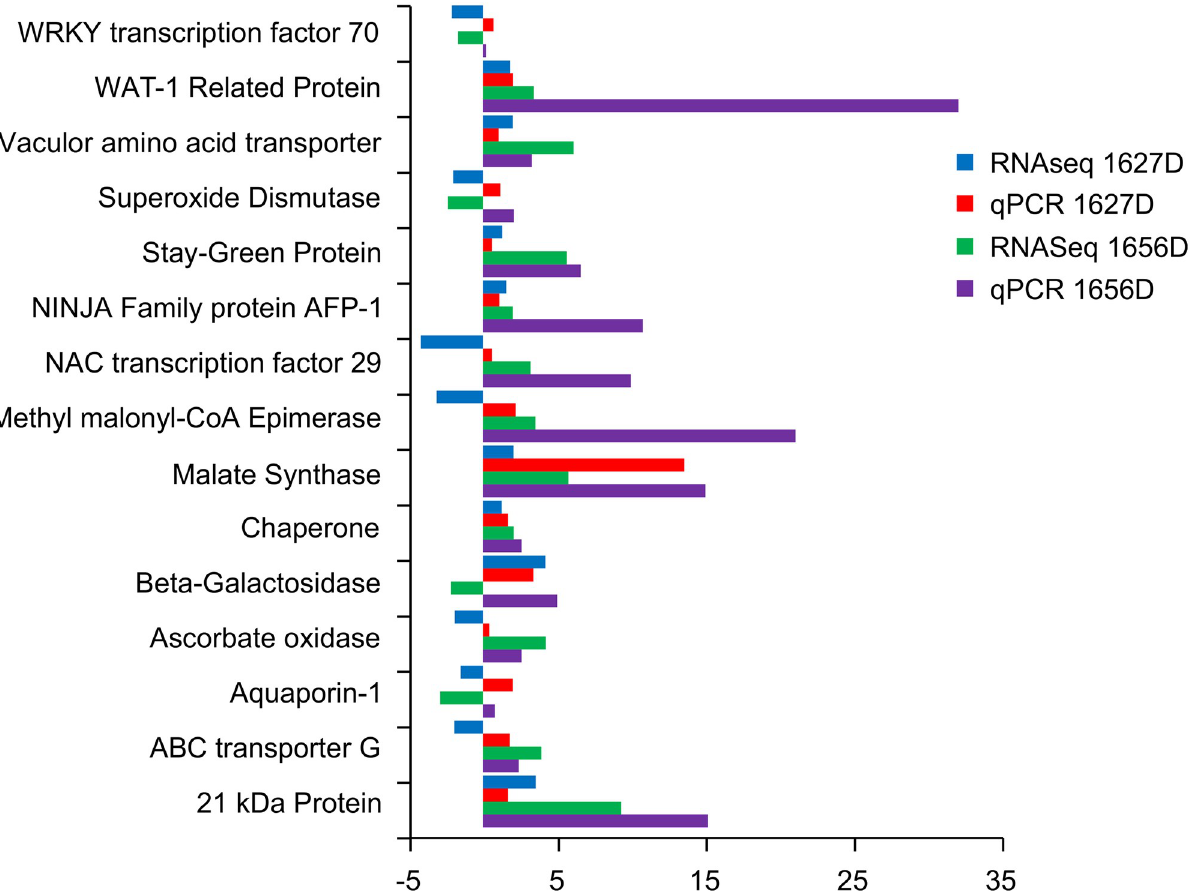
Fig 7. Validation of few selected genes using qRT-PCR in A. drought sensitive (1627) and B. tolerant (1656) onion genotypes under drought stress.